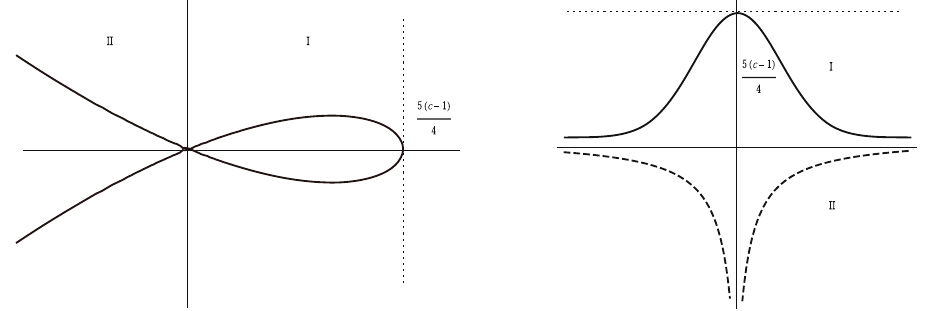
Figure 1: The graphs of the phase - portrait and the wave pro fi le when ( ) p ϕ has three real roots, namely, 0 ( double ) and (